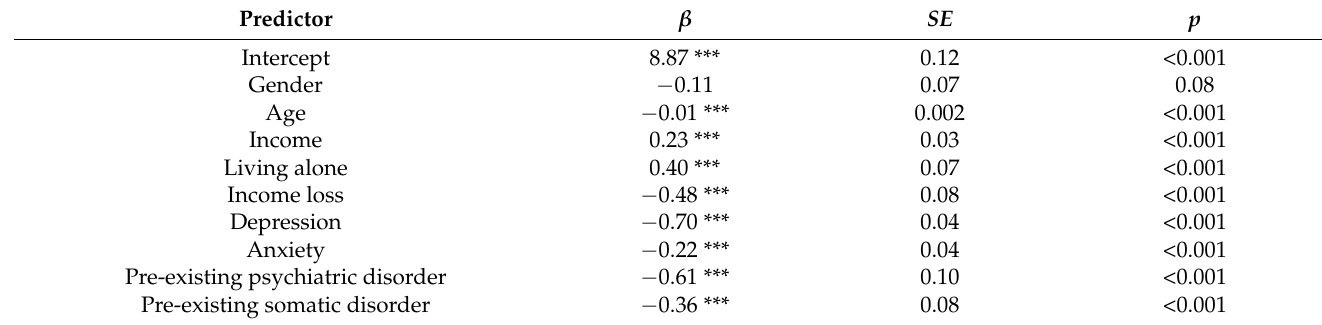
Table 2. Associations of sociodemographic characteristics and mental health with life satisfaction.